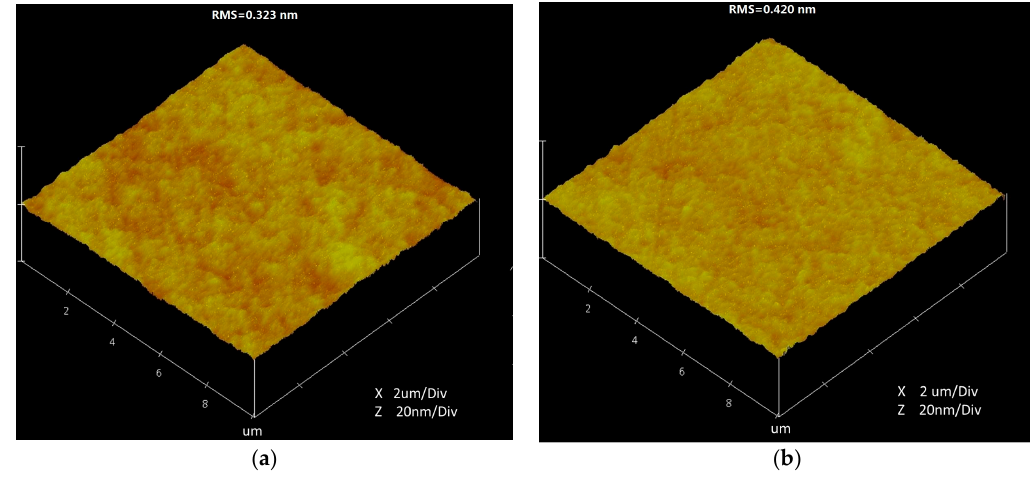
Figure 4. Surface profile measured by AFM: ( a ) ultra-high reflector; ( b ) single crystal silicon substrate.